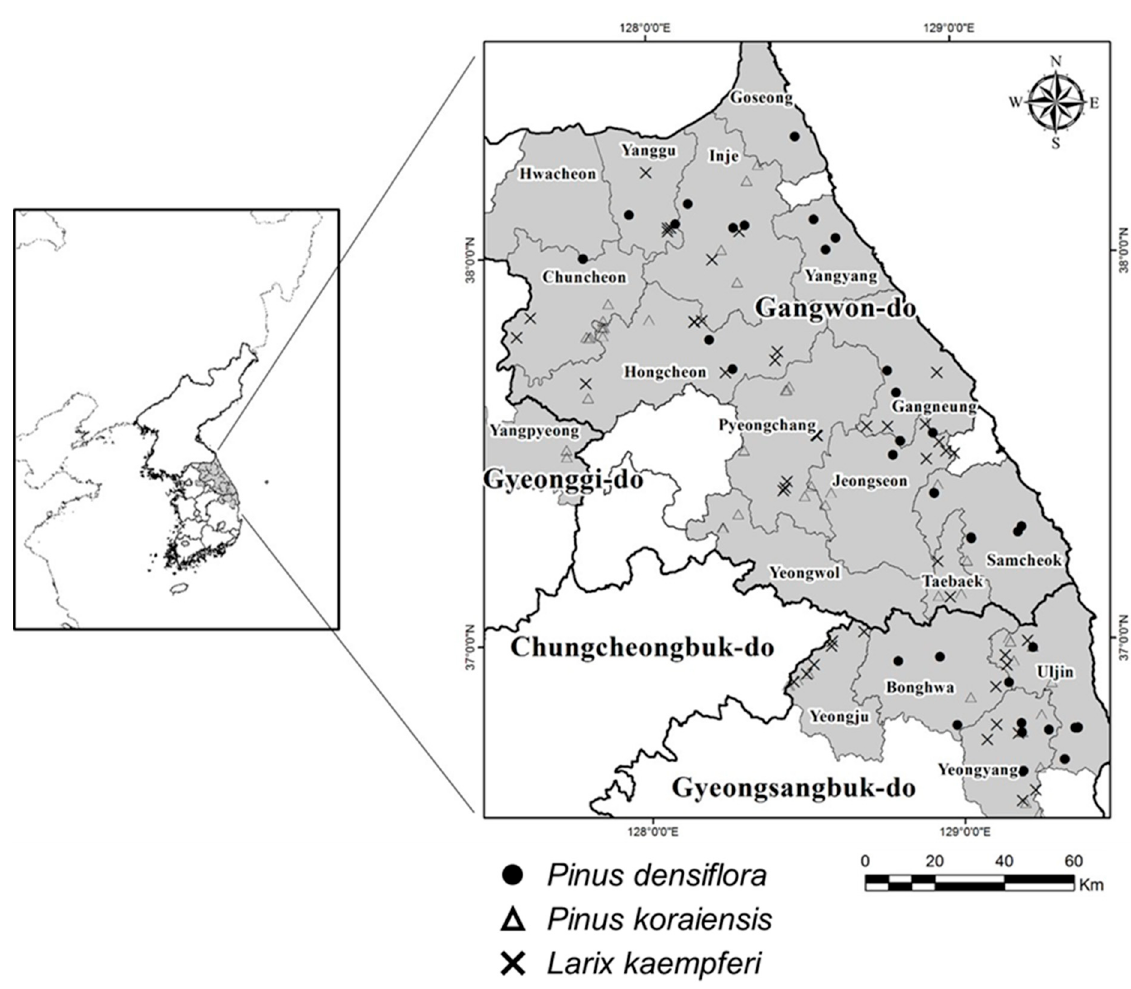
Figure 1. Study sites and plot location by species from which sample trees were collected for stem analysis and model development. analysis and model